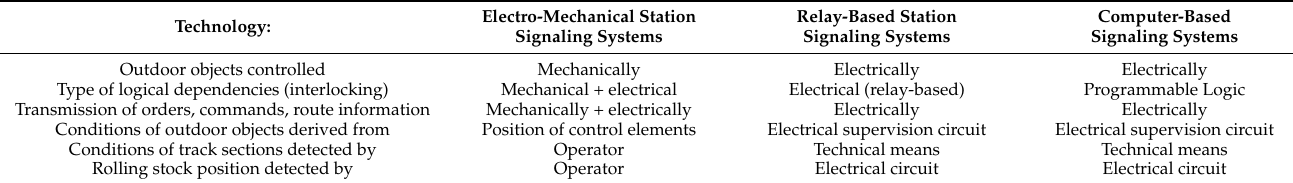
Table 1. Brief characteristics of considered